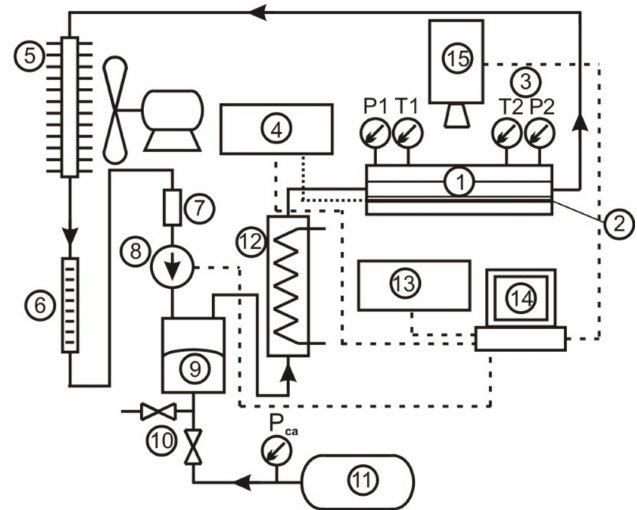
Figure 1. Flow loop. 1—Measurement module with the minichannel (details in Figure 3), 2—Heating copper block, 3—Temperature and pressure sensors, 4 DC power supply, 5—Cooler with